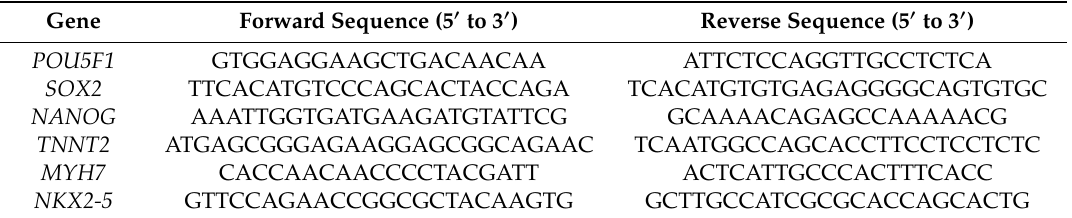
Table 1. Primer Sequences for real-time PCR